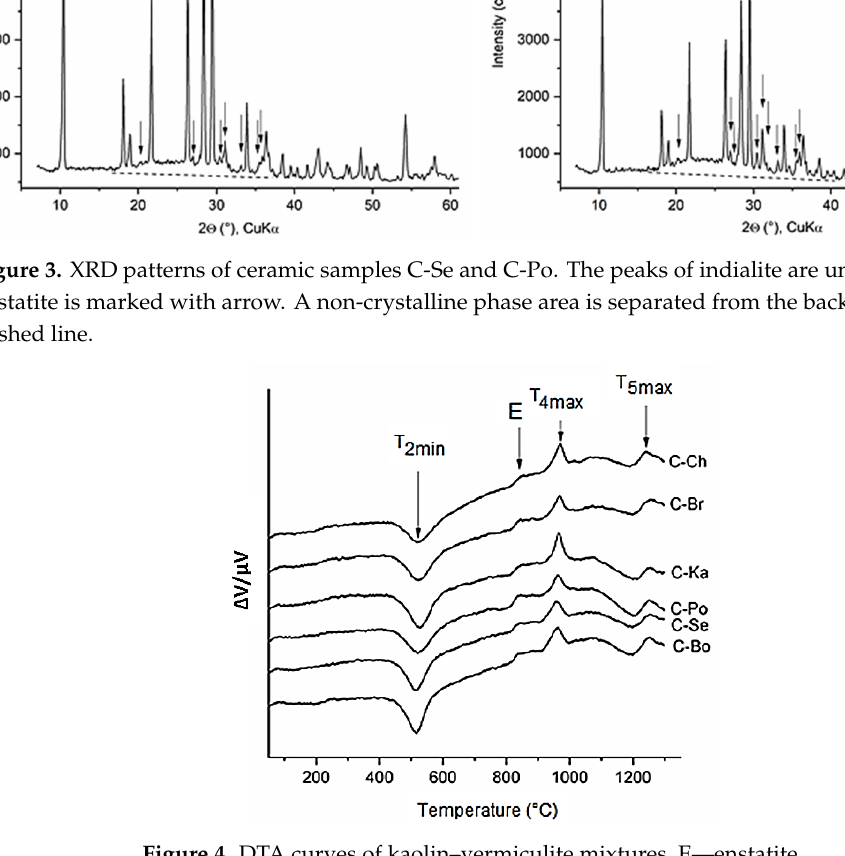
Figure 4. DTA curves of kaolin–vermiculite mixtures. Figure 4